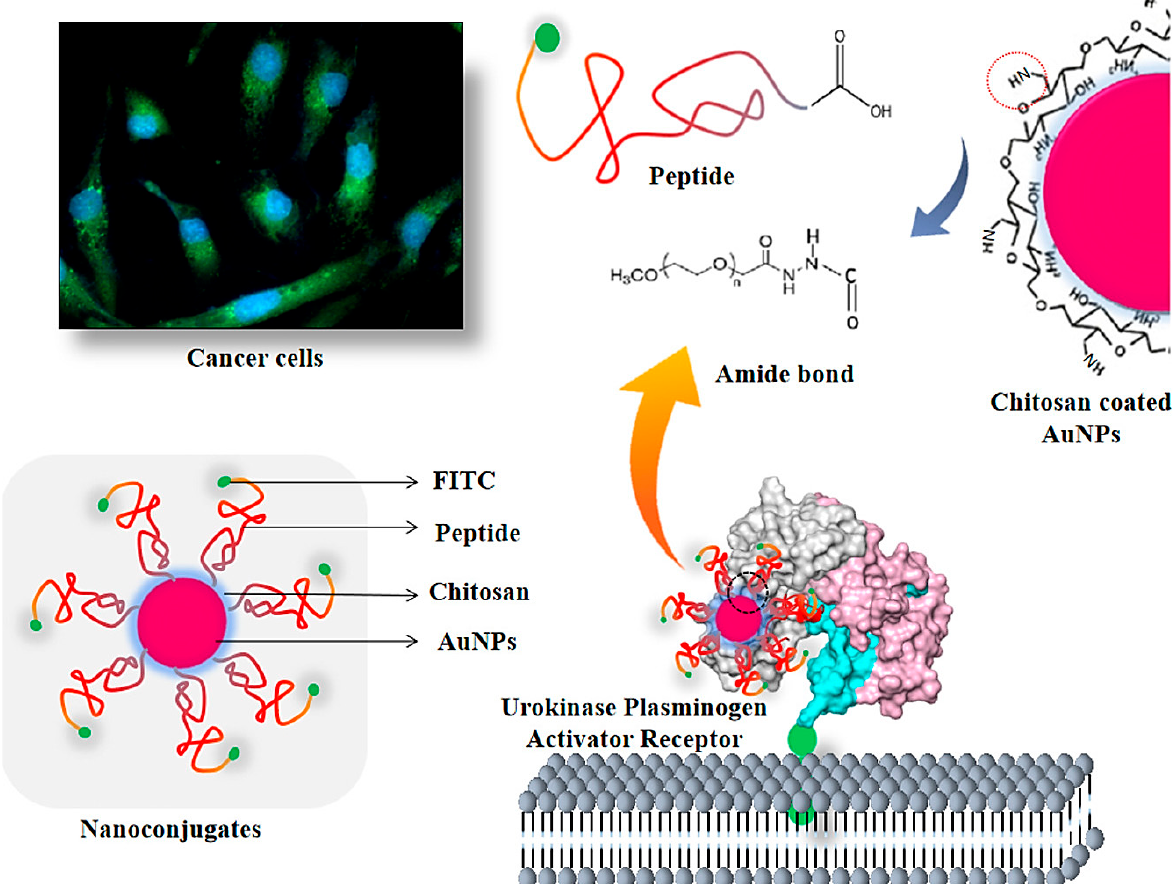
Figure 3. A nanosystem constructed from chitosan polymer and peptide-functionalized Au nano- materials as a nanoprobe for specific detection and imaging of a urokinase plasminogen activator receptor in cancers. Adapted from Ref [59] with permission. Copyright 2021 Elsevier.